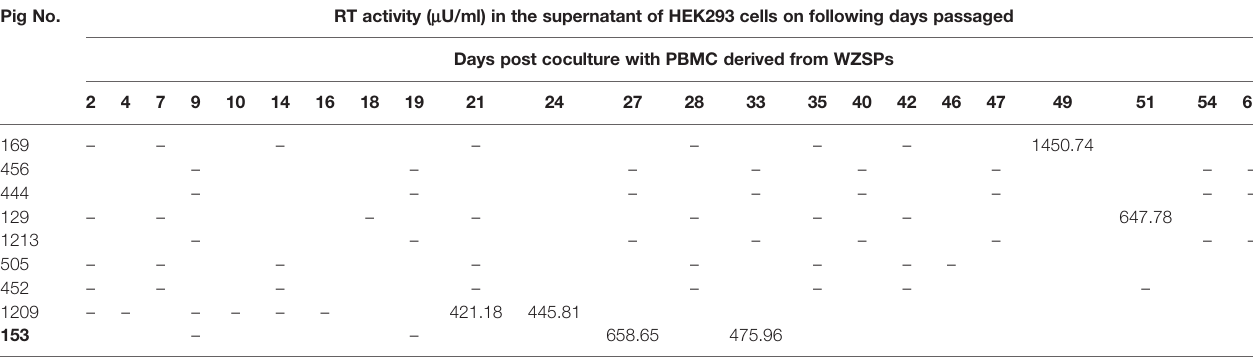
TABLE 1 | Reverse transcriptase (RT) activity in the supernatant of HEK293 cell cocultured with PBMC derived from WZSPs. Pig